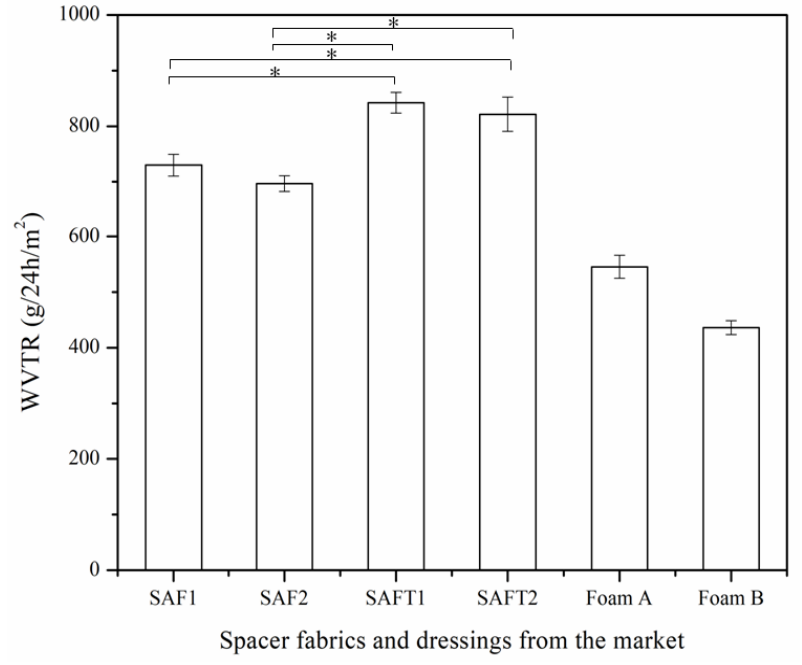
Figure 10. WVTRs of the spacer fabrics and foam dressings from the market. * p <